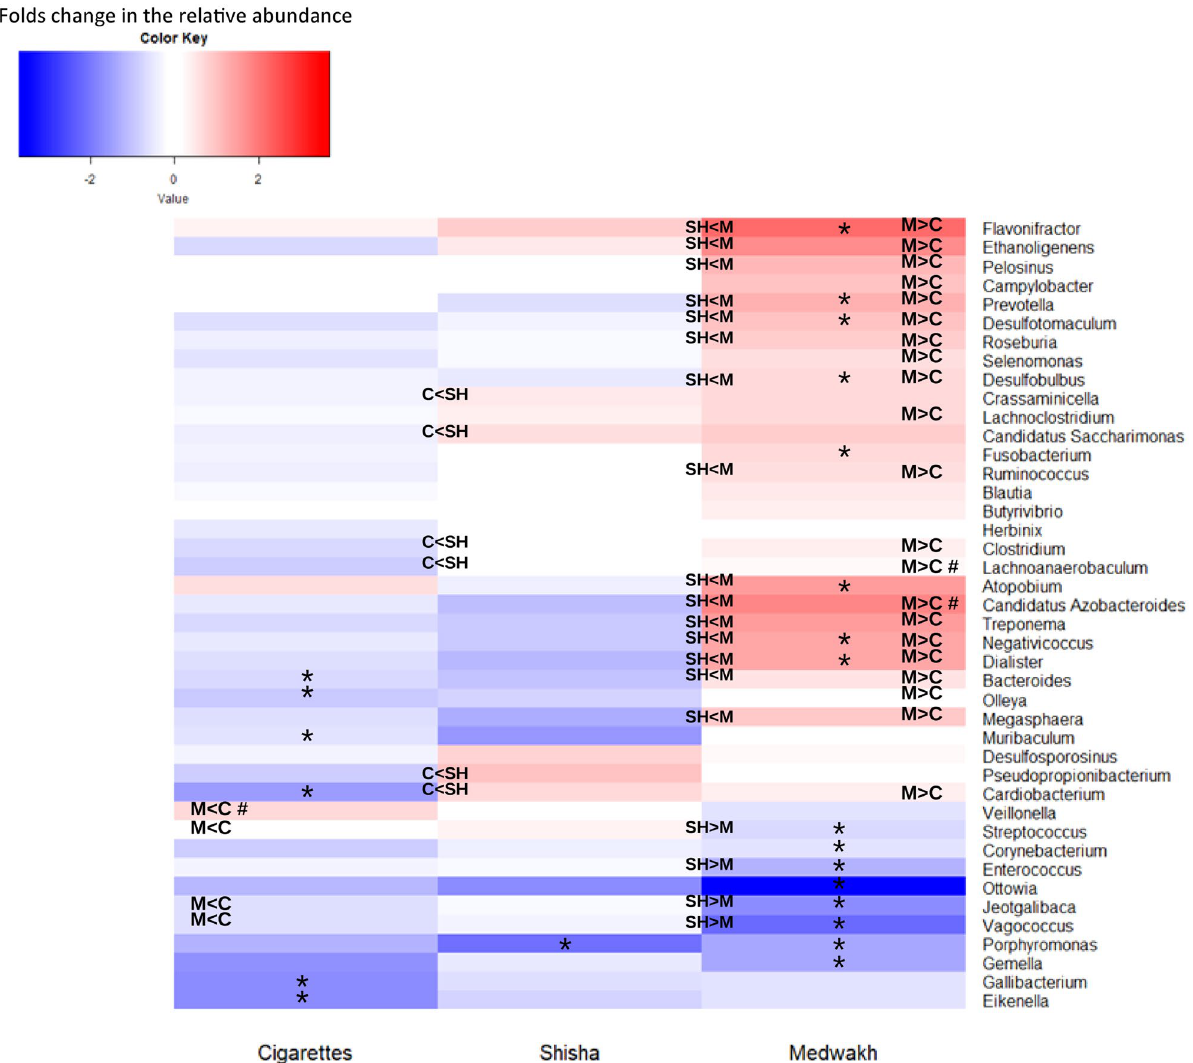
Figure 1. Significant log2 fold change of genera abundances in cigarette, shisha, or medwakh smoking groups compared to non-smokers (log2 tobacco vs log2 non-smokers). Red indicates an increase and blue indicates a decrease in the relative abundance of each genus compared to non-smokers. *Significant difference between each tobacco group and non-smokers; #significant difference exclusively in patients with severe periodontitis; M medwakh smokers, C cigarette smokers, SH shisha